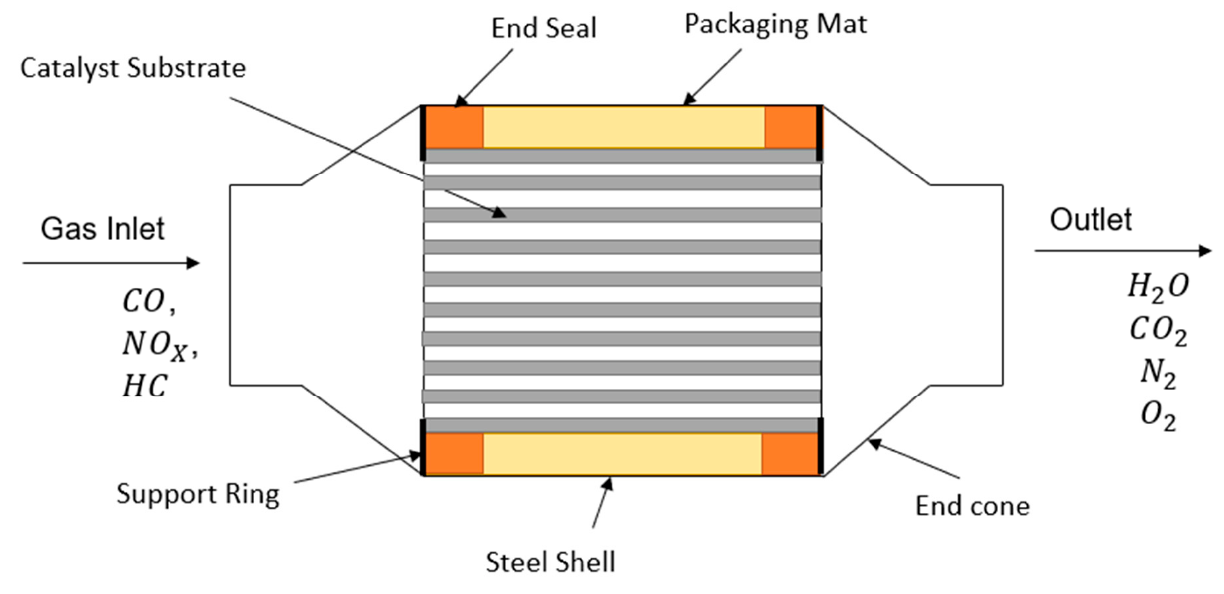
Figure 1. Automobile catalytic converter. Adapted from [25,26].